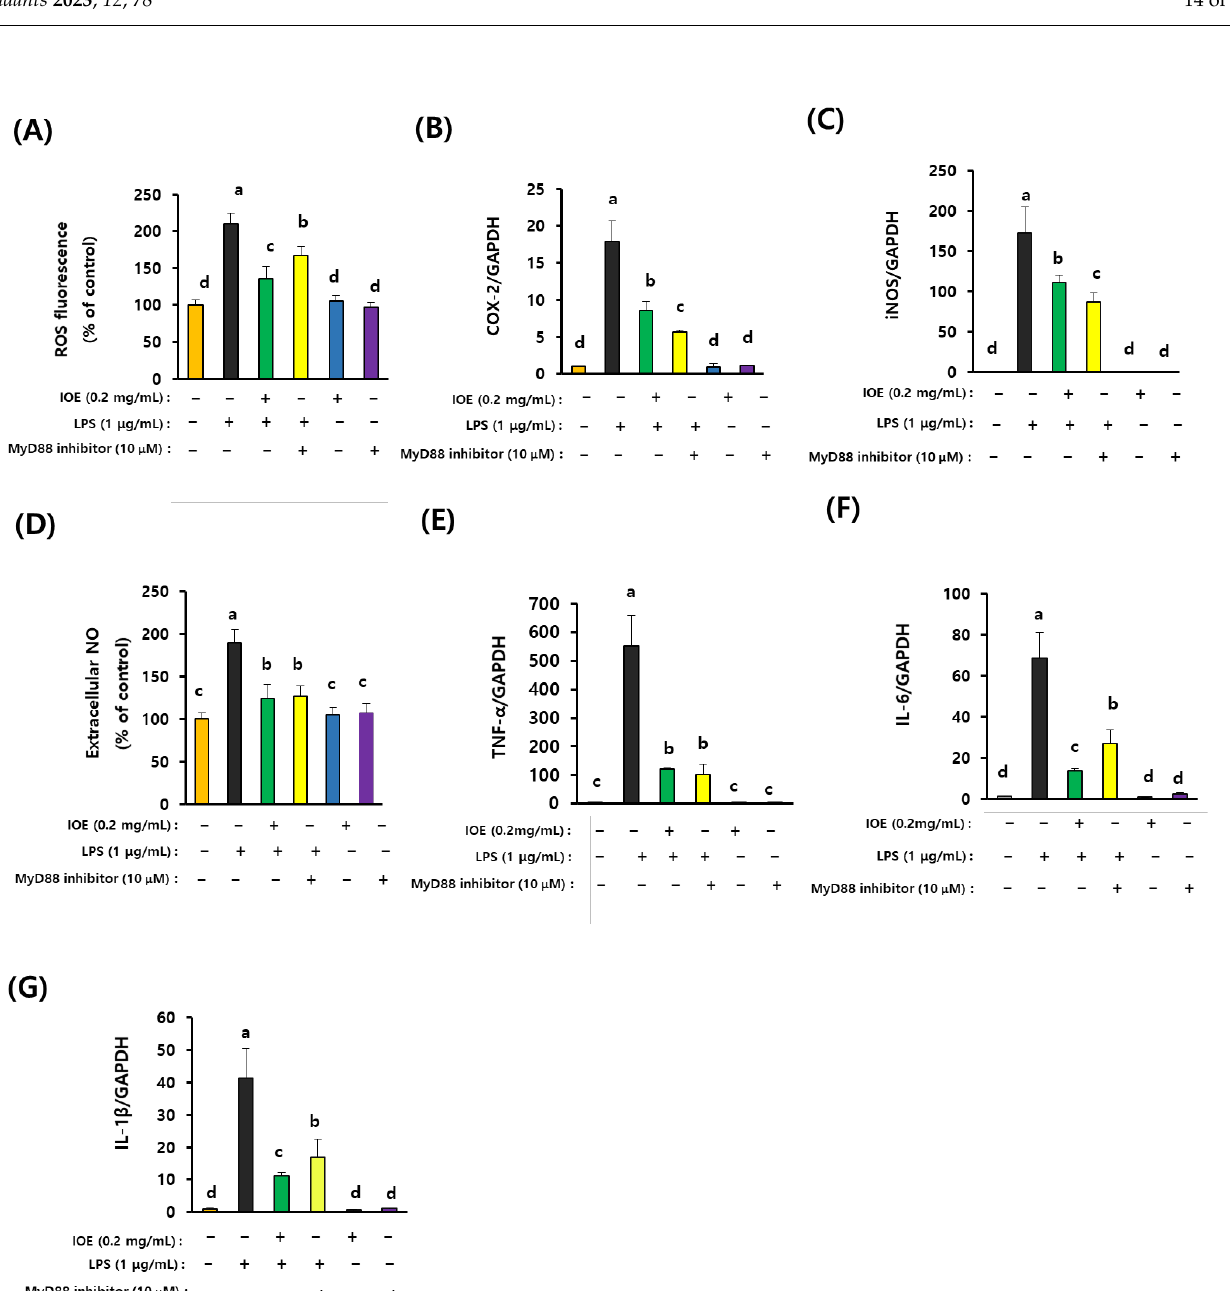
Figure 10. IOE showed equivalent anti-inflammatory activity with MyD88 inhibitor. The inhibitory activity of IOE (0.2 µ g/mL) was compared with MyD88 inhibitor (10 µ M) on the LPS-induced expression of inflammatory mediators such as ROS ( A ), COX-2 ( B ), iNOS ( C ), extracellular NO ( D ), TNF- α ( E ), IL-6 ( F ), and IL-1 β ( G ) in C6 glioma cells. These experiments were repeated three times with similar results. Data shown are the mean ± SD and different letters (a–d) indicate the significant differences among treatments ( p < 0.05). Each value is assigned as a, b, c and d sequentially from the highest value.